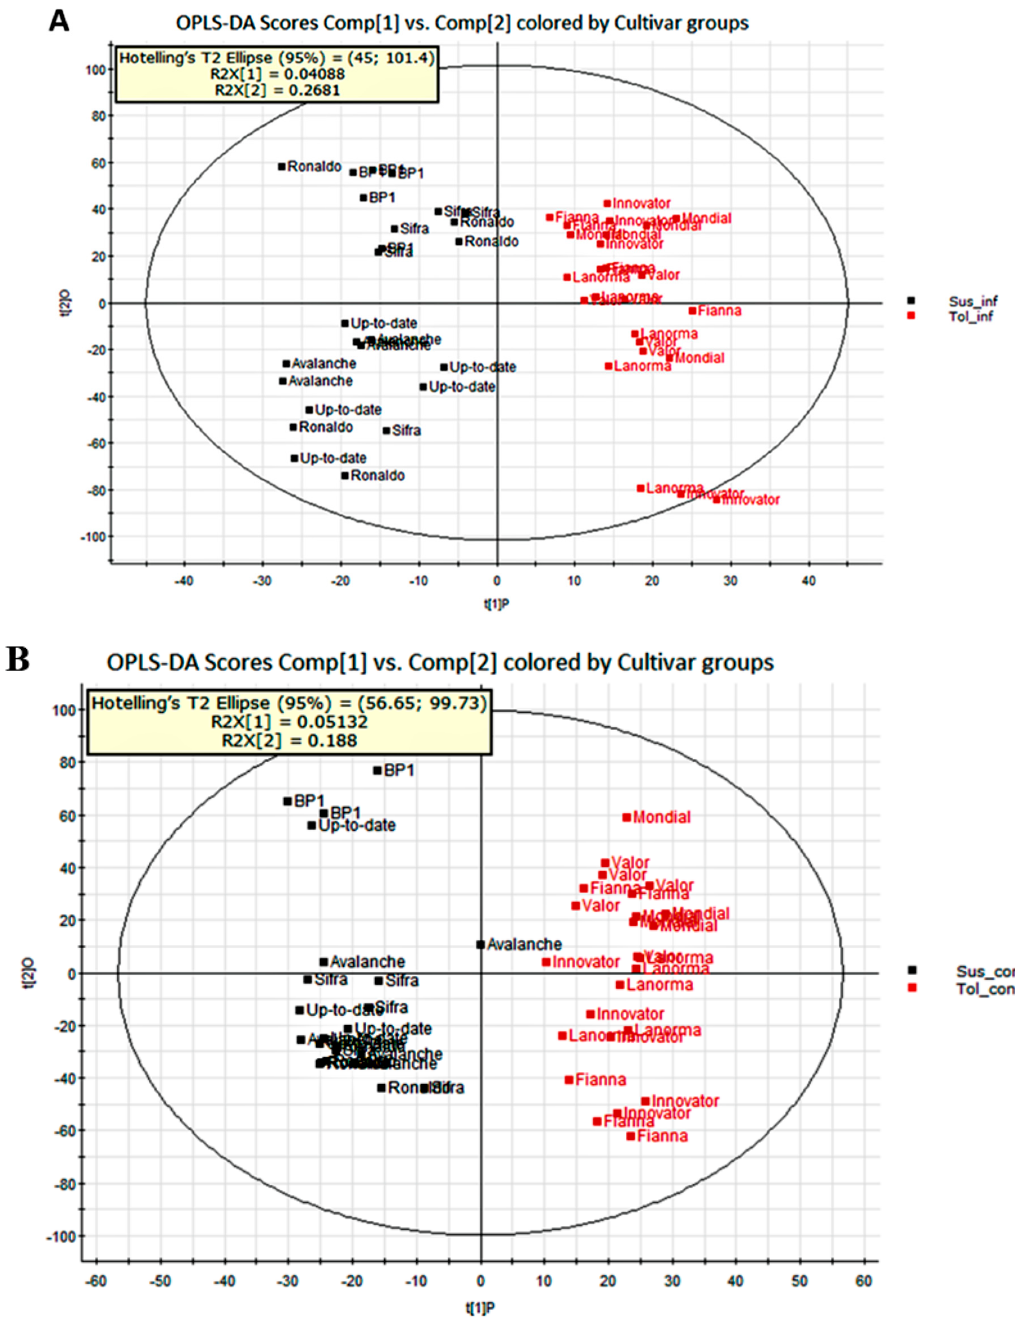
Figure 3. Orthogonal partial least squares discriminant analysis score plots showing a distinct separation between: ( A ) five tolerant inoculated cultivars (red) vs. five susceptible inoculated cultivars (black), ( B ) five tolerant uninoculated cultivars (red) vs. five susceptible uninoculated cultivars (black). Dots represent five replications of each cultivar.